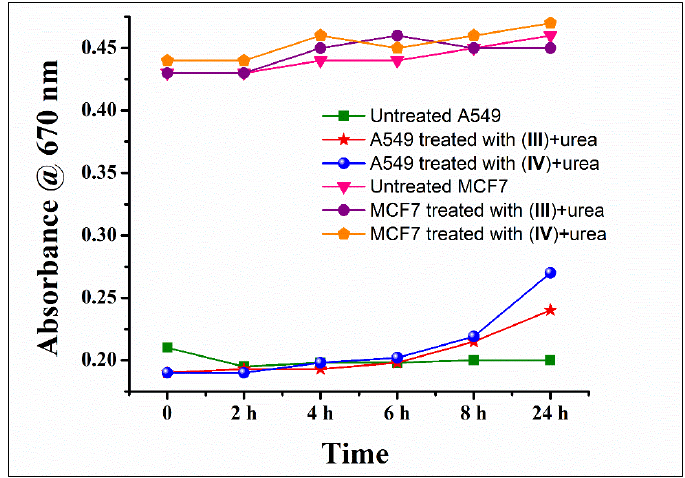
Figure 2. Urease mimetic activity of [Co(trien)Cl 2 ]Cl ( III ) and [Co(tren)Cl 2 ]Cl ( IV ) measured extracellularly in the cell culture medium. The absorbance at 670 nm corresponds to the ammonia concentration generated in response to the catalytic urease activity.